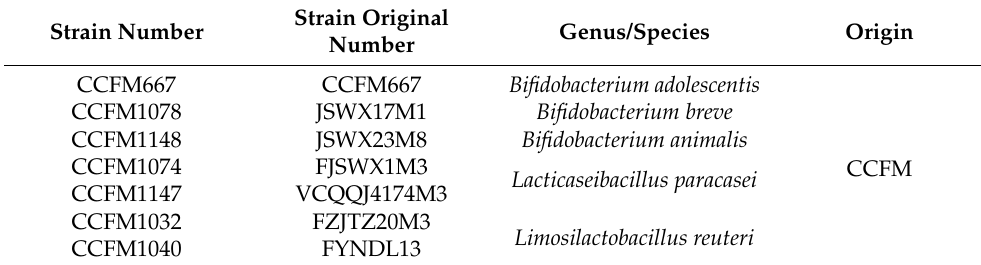
Table 1. Information of